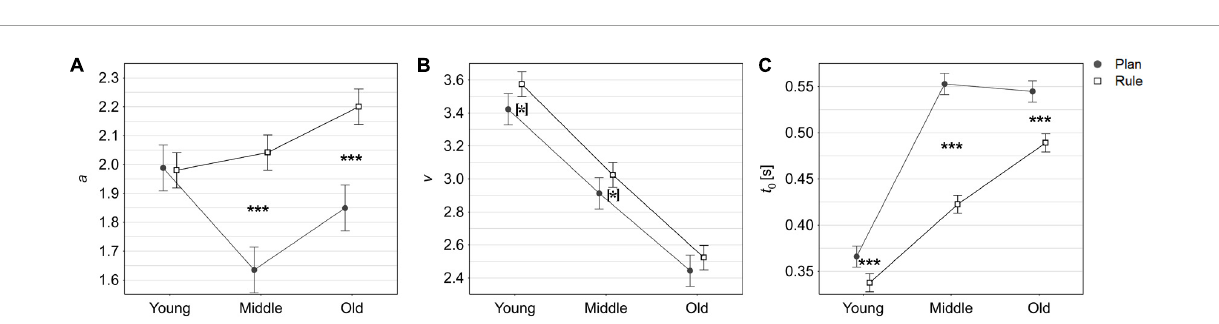
FIGURE4 Drift diffusion model (DDM) parameter estimates from simulated datasets. Error bars represent 95% confidence intervals. [*] denotes uncorrected p -values < 0.05; *** denotes Bonferroni corrected p -values < 0.001 of within-group t -test task comparisons. (A) DDM boundary separation parameter ( a ) by age group and task. (B) DDM drift rate parameter ( v ) by age group and task. (C) DDM non-decision time parameter ( t 0 ) in seconds by age group and task. Drift rate, v : the rate of information accumulation (speed of the decision process), boundary separation, a : the distance between decision thresholds (response caution), and the duration of non-decision components t 0 : stimulus encoding, preparation of motor response, visualization (action